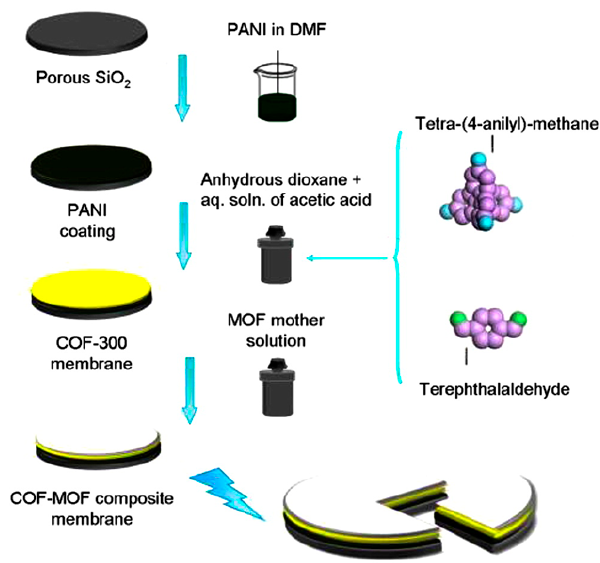
Figure 42. Schematic representation of the fabrication of covalent-organic frameworks-metal–organic framework (COF-MOF) composite membranes. (adapted with permission from ref. [137]).